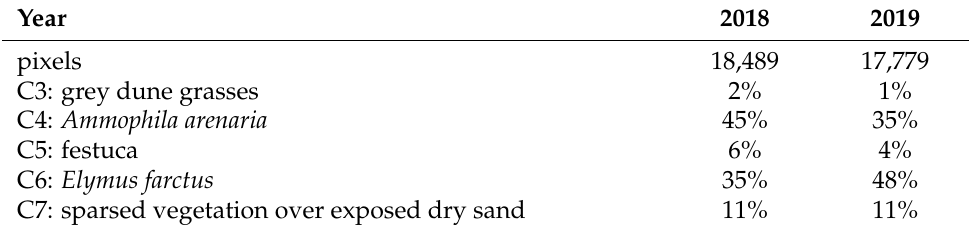
Table 2. Classified Ammophila arenaria spectral